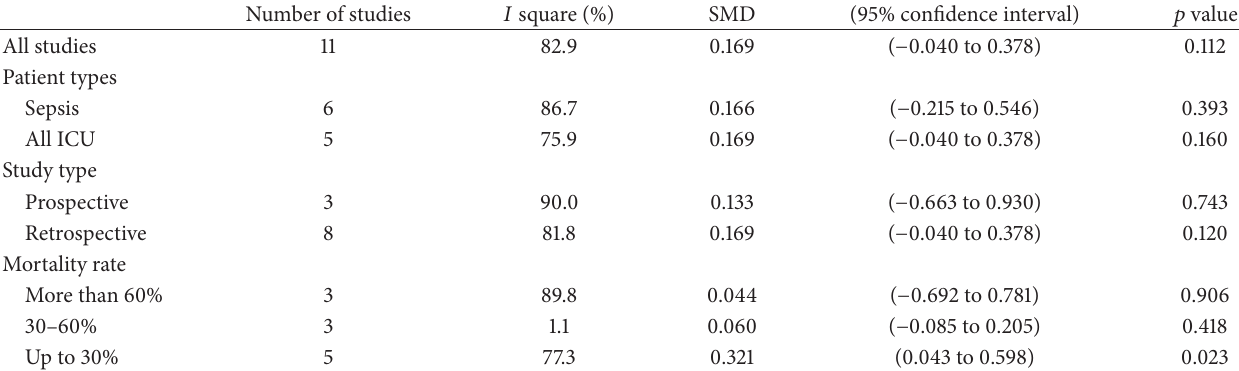
Table 2: Heterogeneity of pool mean differences of MPV in all studies and subgroup of patient type, study type, and mortality rate.